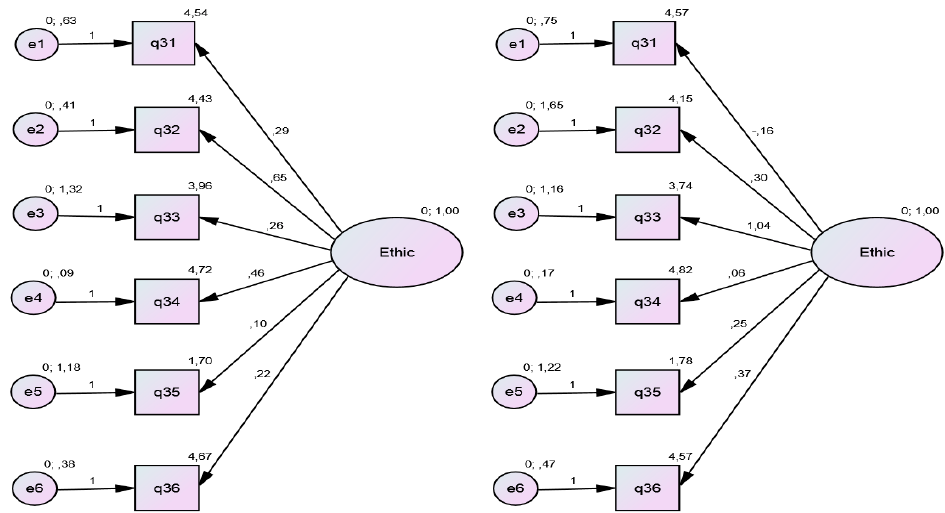
Figure 1. Reflective model—confirmatory factor analysis (CFA) of the ethics construct, based on six